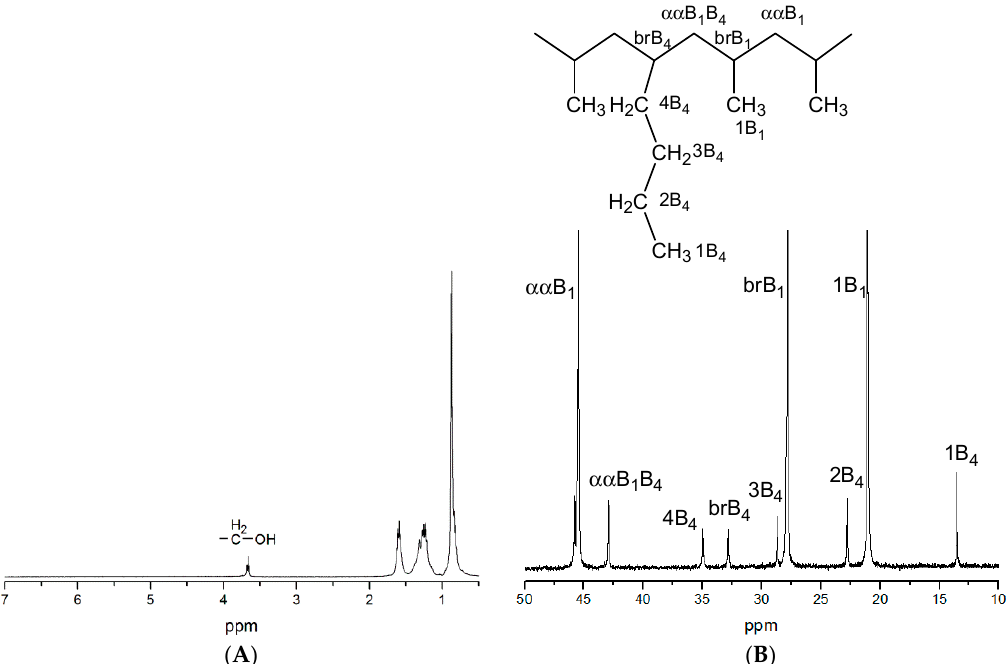
Figure 1. ( A ) Typical 1 H NMR spectrum of functional copolymer (entry 5); ( B ) 13 C NMR spectrum of non-functional copolymer (entry 10).